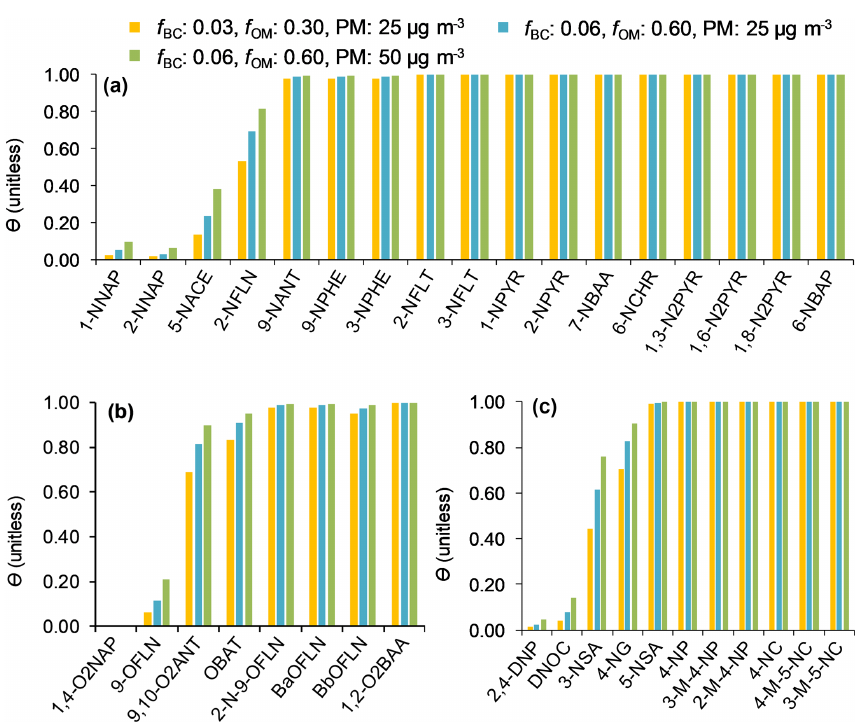
Figure 6. Particulate mass fractions θ estimated at 273K using a multi-phase gas-particle partitioning model for NPAHs (a) , OPAHs (b) , and NMAHs (c)